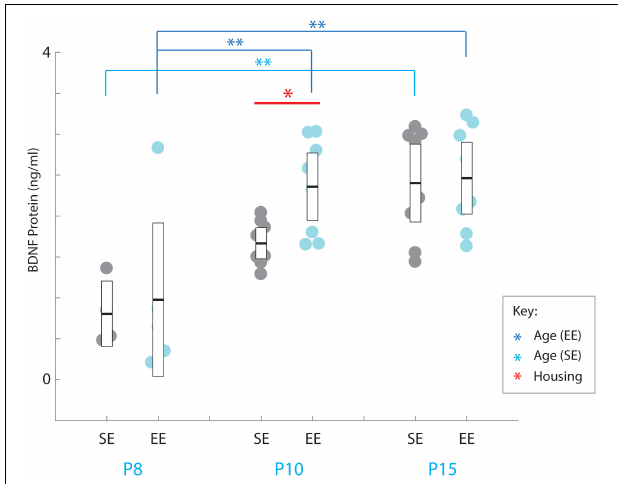
Table 5 ; Figure 4 , dark blue brackets and asterisks: brackets show age groups that were significantly different indicated